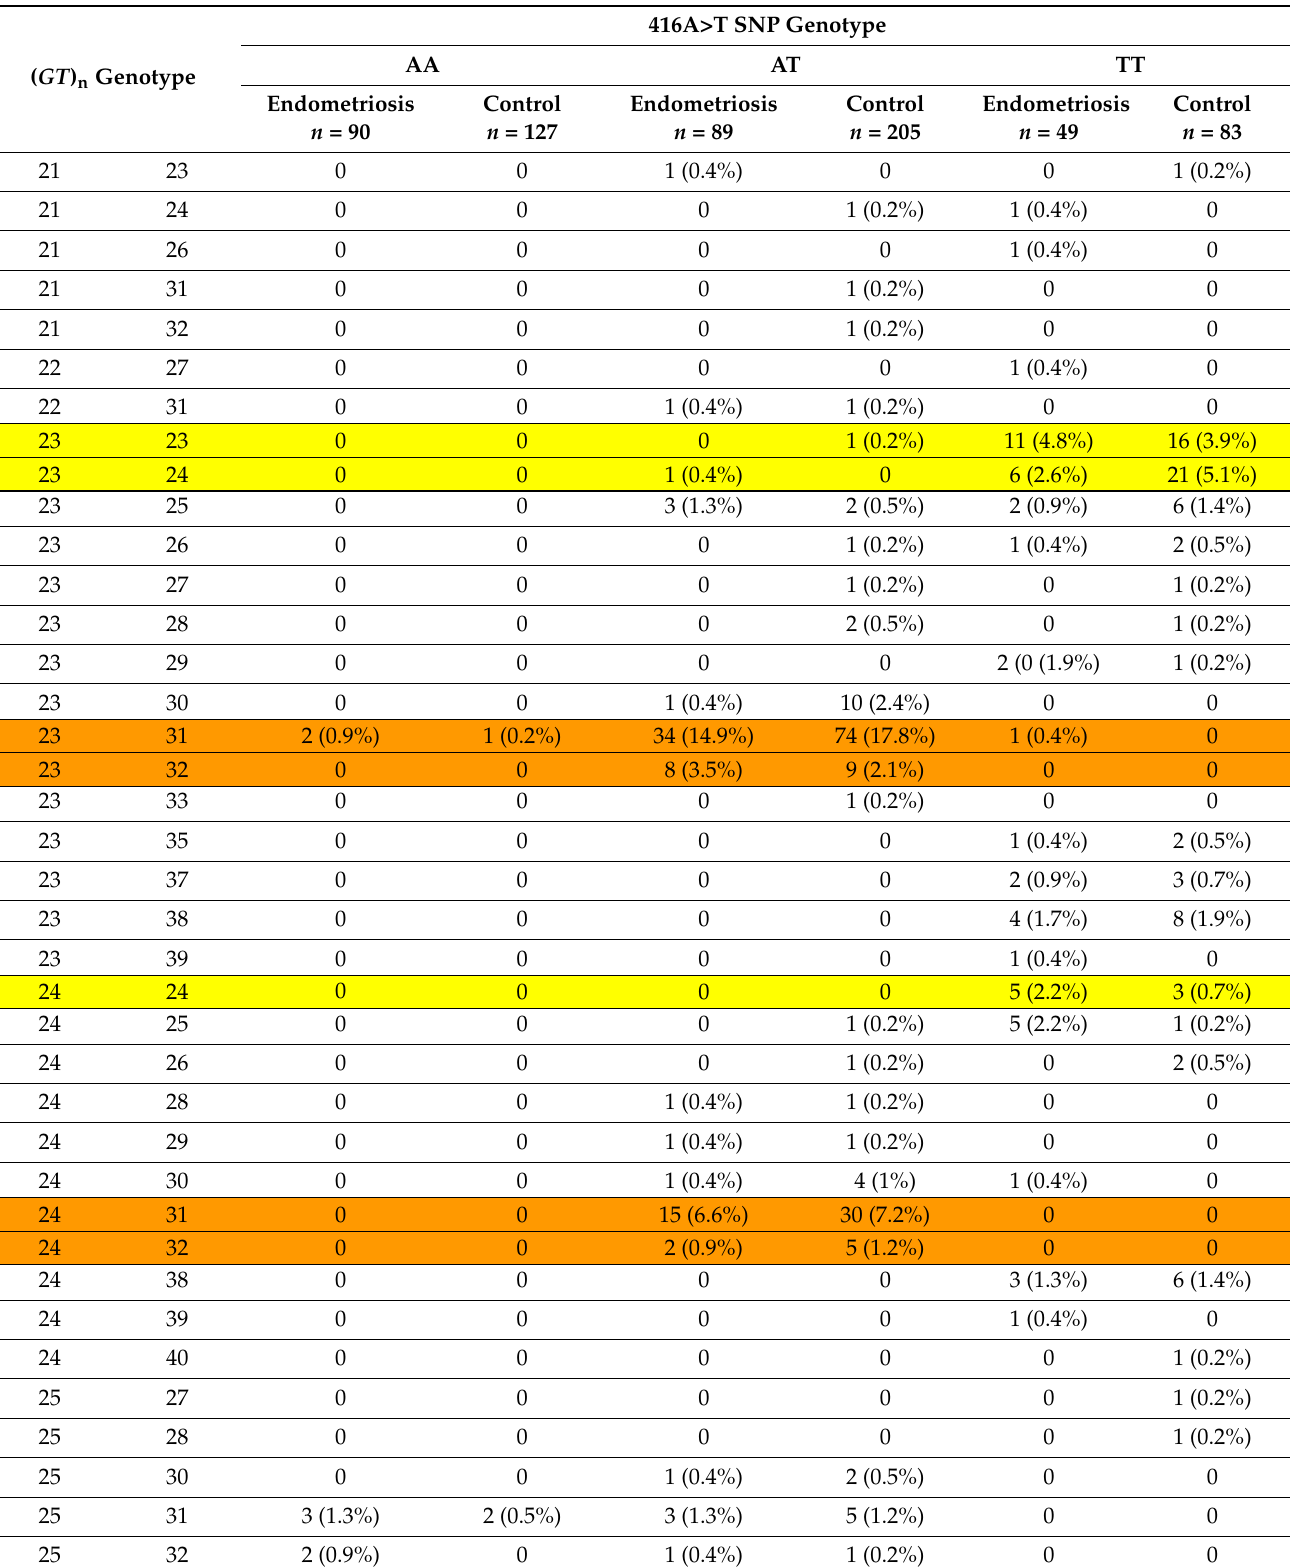
Table 2. Distribution of ( GT ) n variants in relation to − 416A>T genotypes of HMOX1 gene in women with endometriosis and control